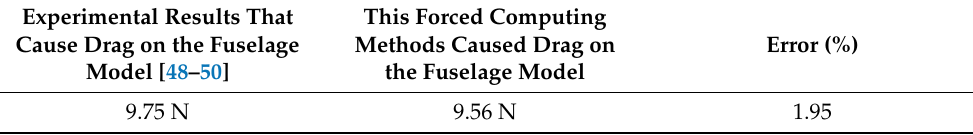
Table 1. Results of Drag by both computational and experimental outcomes.